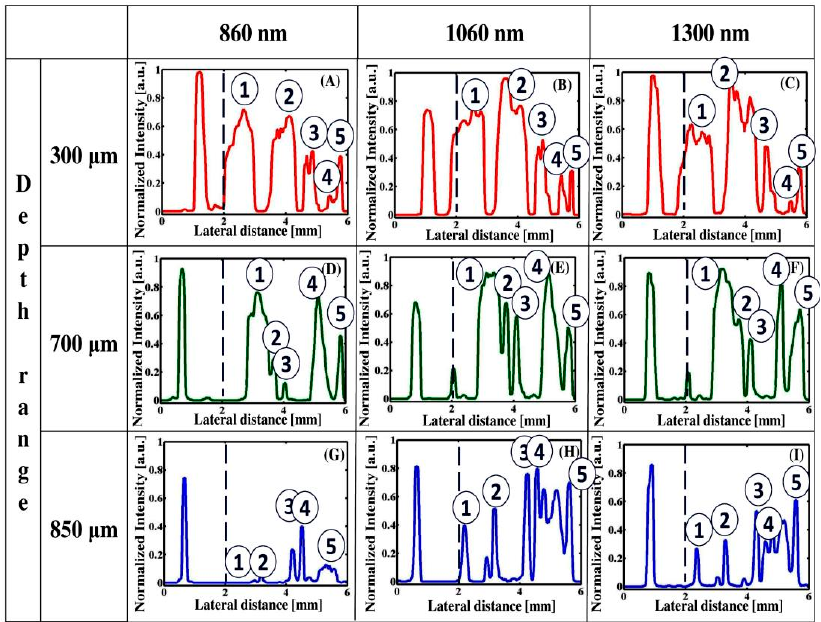
Figure 7. Transverse direction intensity profiles obtained from the enface images. Red plots correspond to the transverse direction intensity plot obtained from the depth range of 300 μ m, green plots correspond to the transverse direction intensity plot obtained from the depth range of 700 μ m, and blue plots correspond to the transverse direction intensity plot obtained from the depth range of 850 μ m in all the ex vivo cochlea volumetric images. Graphs ( A – C ) indicate transverse intensity fluctuation corresponds to the depth range of 300 μ m, ( D – F ) indicate transverse intensity fluctuation corresponds to the depth range of 700 μ m, and ( G – I ) indicate transverse intensity fluctuation corresponds to the lower depth range of 850 μ m. The inset numbers ( ① ~ ⑤ ) illustrate the five uniform points of interest considered for the quantitative analysis of each depth range. Due to the degraded intensity level of 1350 μ m depth range (specifically in 860 nm), the enface representations were not considered for the transverse intensity detection.